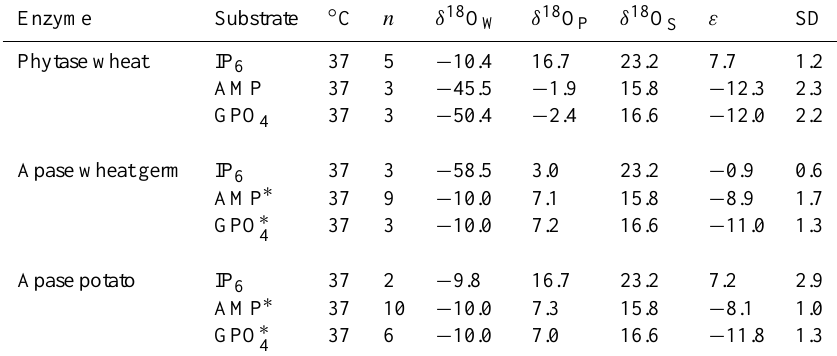
Table 3. δ 18 O values of water ( δ 18 O W ), released phosphate ( δ 18 O P ) and phosphate in organic P compound ( δ 18 O S ) as well as isotopic fractionation ( ε ), which was calculated according to Eqs. (6) and (7) with an assumed δ 18 O CON value of 15‰. Results are from experiments with IP 6 , AMP and GPO 4 as substrates and with phytase from wheat and acid phosphatases from wheat germ and potato. ∗ Values from von Sperber et al. (2014). Enzyme Substrate ◦ C n δ 18 O W δ 18 O P δ 18 O S ε SD Phytase wheat IP 6